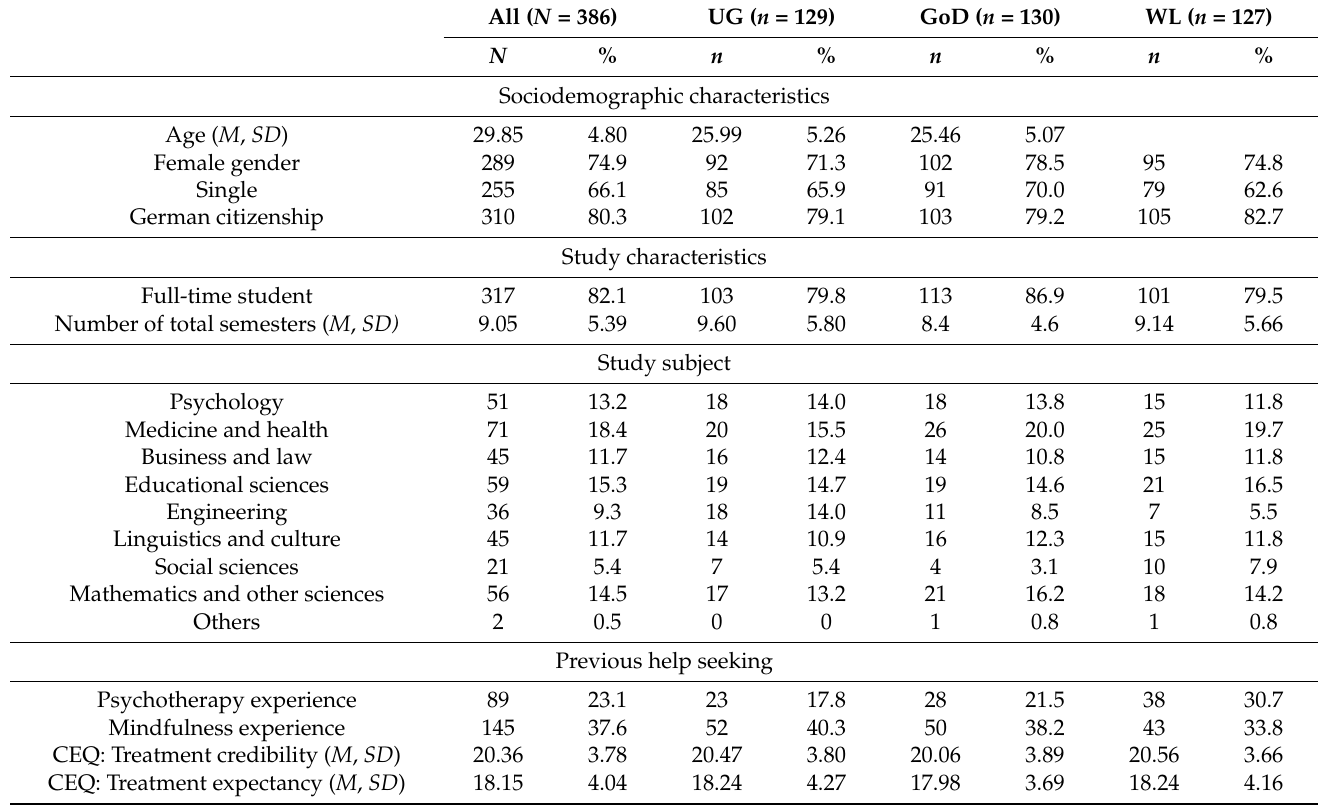
Table 2. Baseline